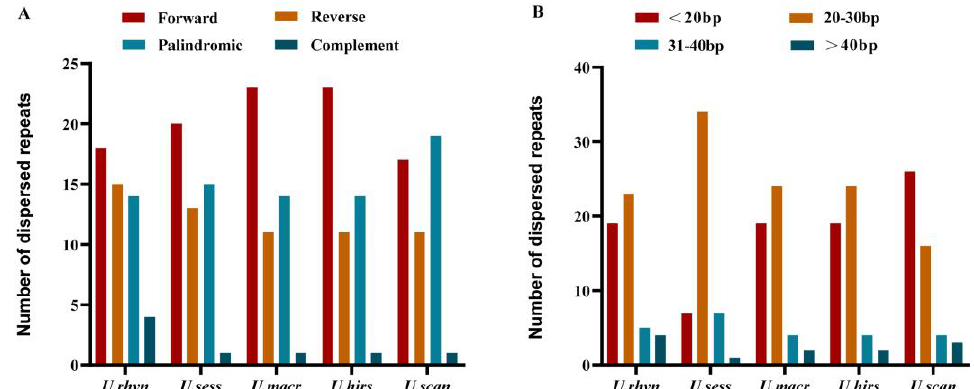
Figure 5. Dispersed repeated sequences analyses in cp genomes for five Uncaria species. ( A ) Statistics of four types of dispersed repeated sequences in five cp genomes; ( B ) Number of the dispersed repeated sequences with different period sizes.